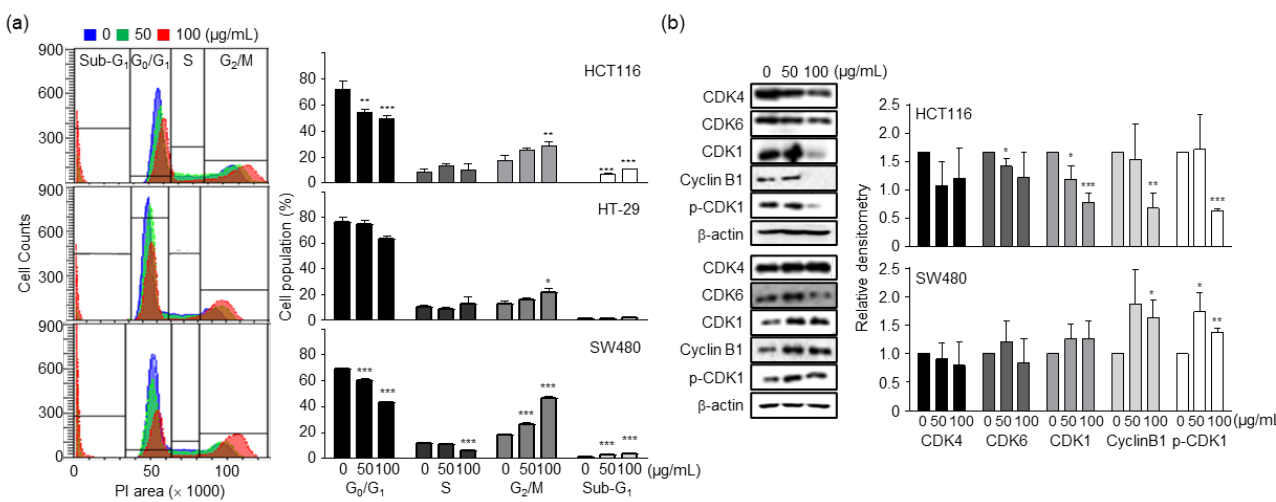
Figure 2. Effects of PSY on cell cycle in human CRC cells. CRC cells were treated with PSY EtOH- Ex for 48 h. ( a ) The treated cells were stained with PI, and the staining was analyzed using flow cytometry. The representative analysis is shown in the left panel. Every PI staining and analysis was performed at least three times in duplicate or triplicate. Cells were quantitated as a percentage of cells in each phase. Data in the right panel represent the mean ± SEM (*, p < 0.05; **, p < 0.01 and ***, p < 0.001 versus control). ( b ) Whole lysates of the treated cells were prepared, and Western blot analysis for CDK1, CDK4, CDK6, Cyclin B1, and phospho (p)-CDK1 was performed, and β -actin was used as an internal control. Data represent the mean ± standard deviation (SD) of three inde- pendent experiments (*, p < 0.05; **, p < 0.01 and ***, p < 0.001 versus control).